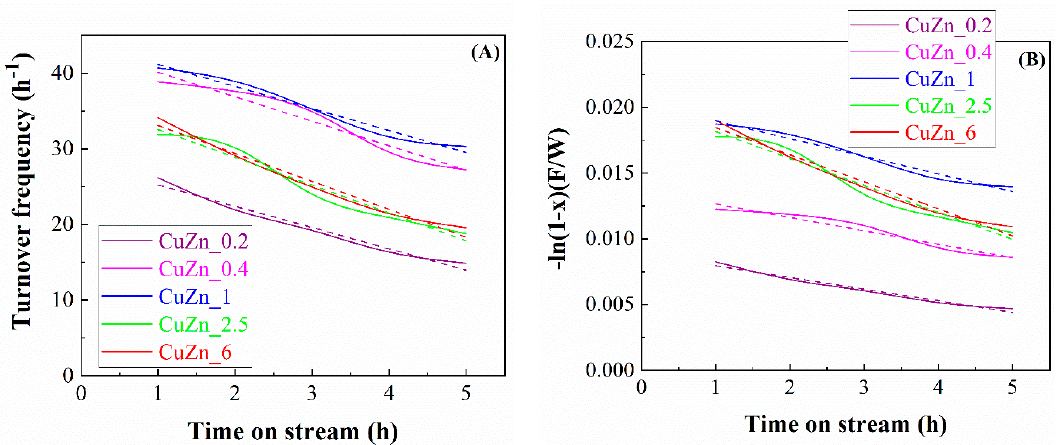
Figure 10. Linearization of TOF values ( A ) and FUR consumption rate ( B ) with time-on-stream for CuZn_X catalysts.